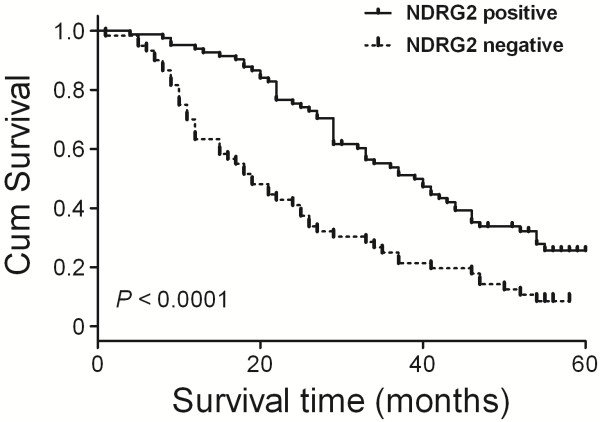
Correlation of the overall survival rate of ESCC patients with NDRG2 expression pattern. Curves were estimated using the Kaplan-Meier method (P < 0.0001). Continuous line represents NDRG2 positive group; dotted line represents NDRG2 negative group.